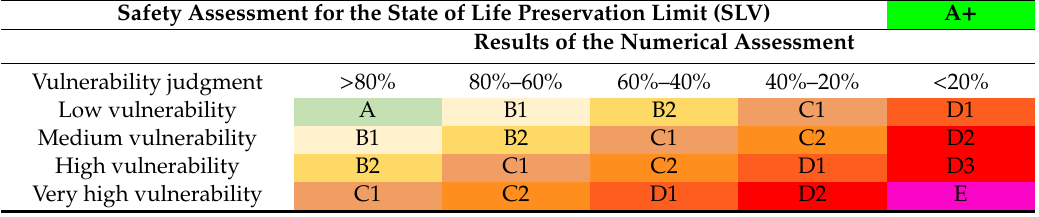
Table 3. Anti-seismic classification